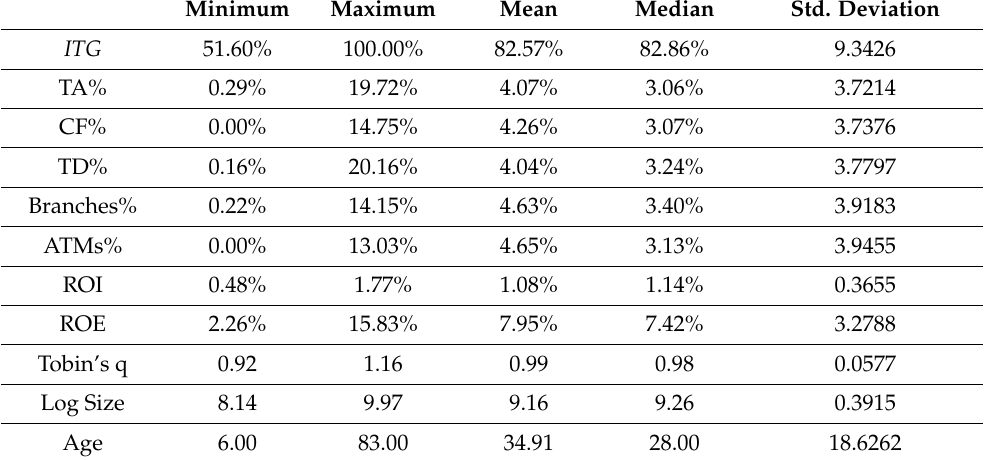
Table 6. Descriptive statistics of the study